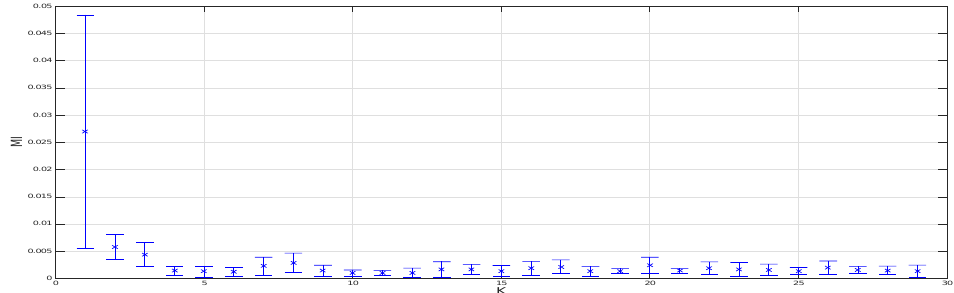
Figure 3. Mutual information for one of the